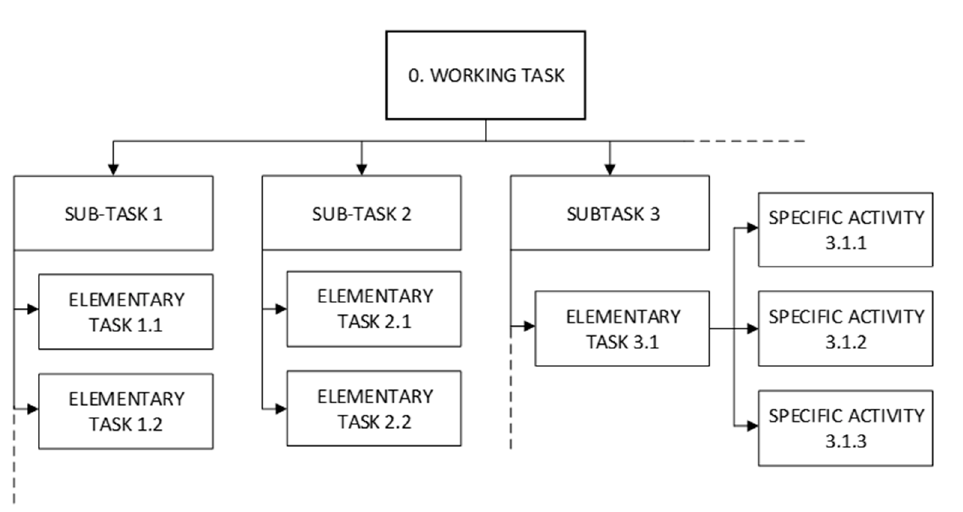
Figure 2. Scheme of the hierarchical task analysis (HTA) method used in the analysis (adapted from [26]).